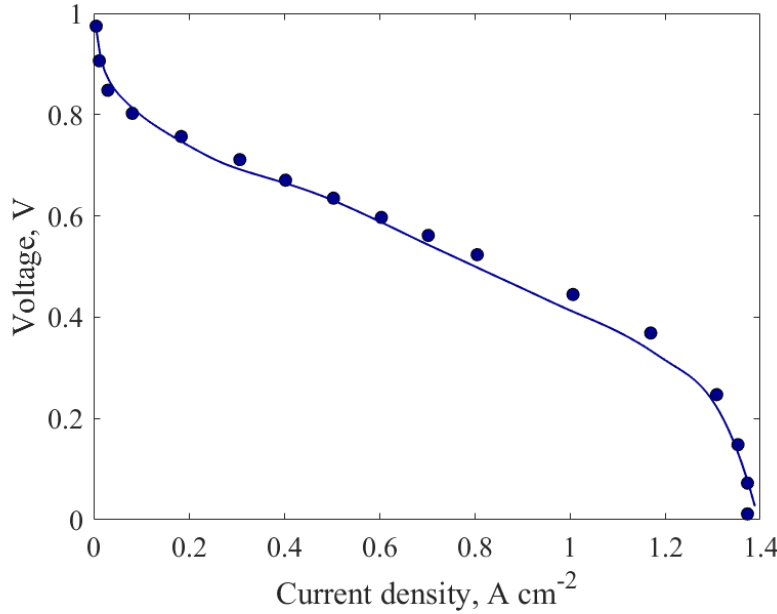
Figure 4. Experimental (points) and predicted (line) polarization curve for case b.